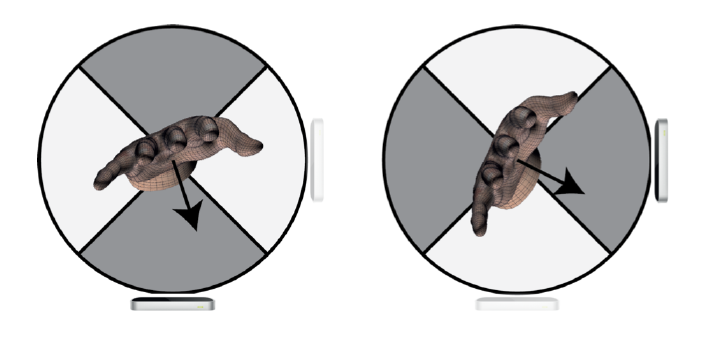
Figure 4. Binary switch approach: depending on the orientation of the hand, one sensor data are used, while the others are discarded; black arrows indicate the palm normal